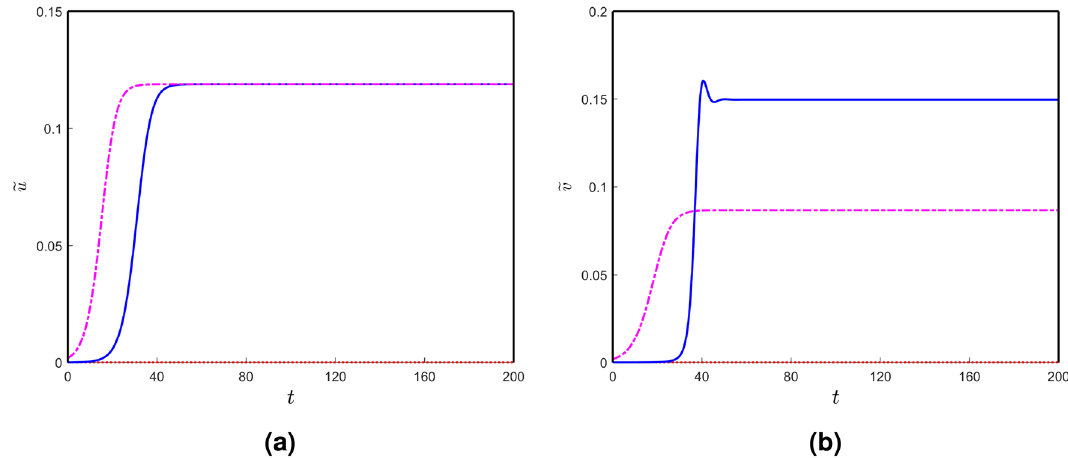
Figure 4. (Color online) Node-wise toxic propagations over time: ( a ) toxic A β and ( a ) toxic τ P.